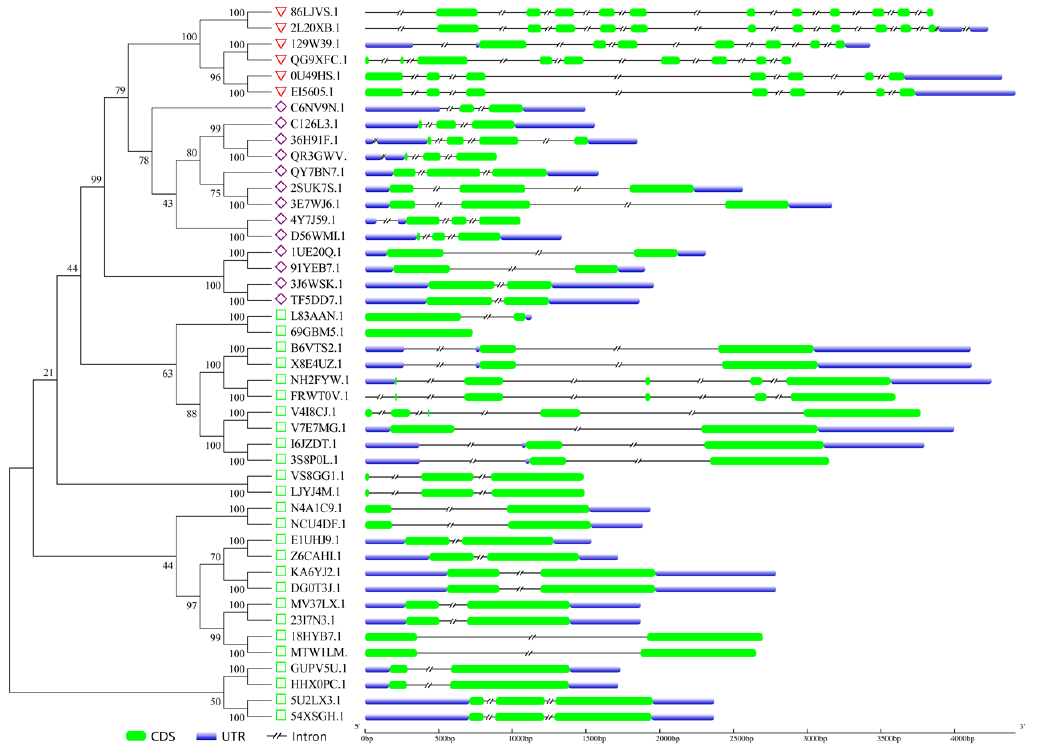
Figure 3. Gene structures of all identified GATA family members in A. hypogaea L.